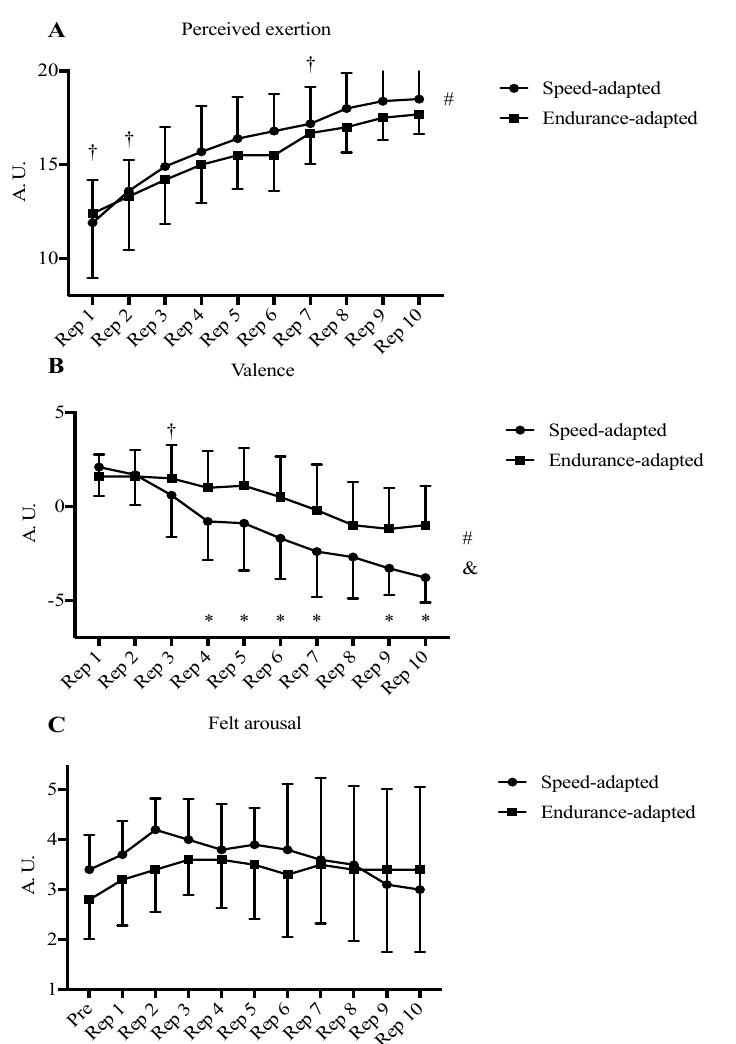
Figure 2. Mean ( ± SD) ratings of perceived exertion ( A ), valence ( B ) and felt arousal ( C ). † indicates the differences between successive repetitions ( p < 0.05, d ≥ 0.61) in speed-adapted milers. * indicates the differences between groups after each repetition. # and & indicates main time and group effect, respectively.